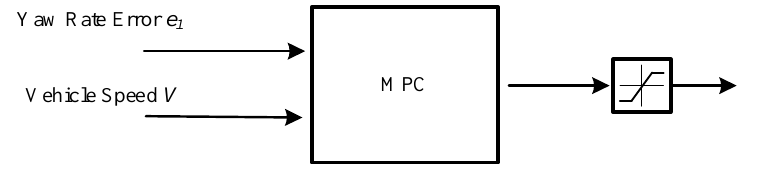
Figure 6. Model Predictive Control scheme.